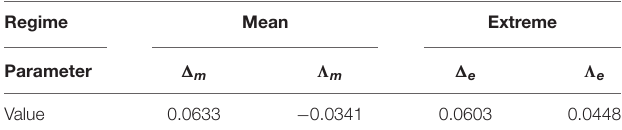
TABLE 2 | Gumbel distribution function, localization, and scale